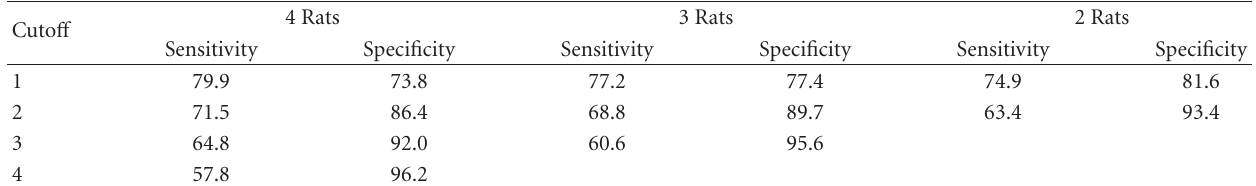
Table 3: Average sensitivity and specificity for 12 groups of 4, 3, and 2 rats.